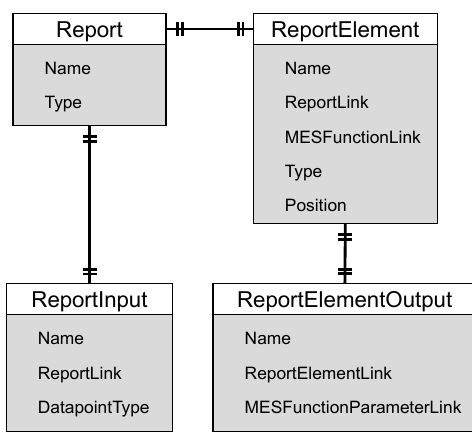
Figure 6. ERD of tables for report model.